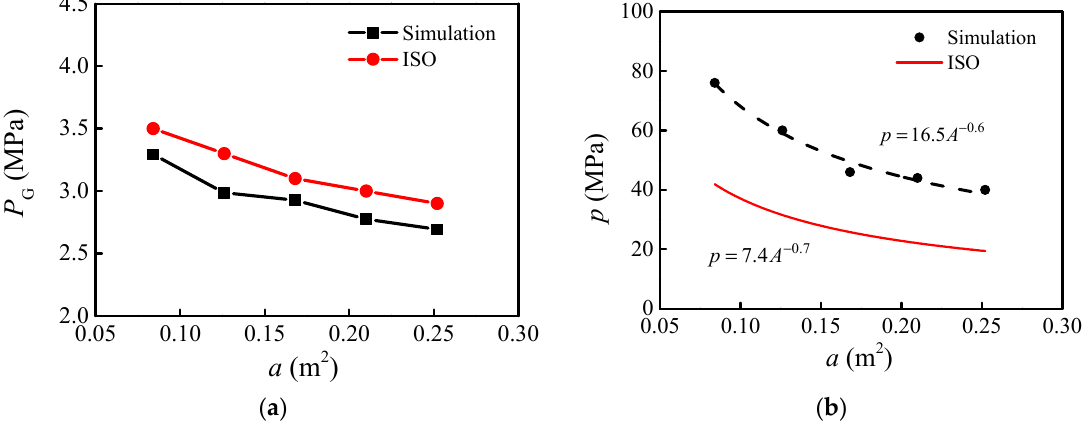
Figure 12. Effect of the contact area on high-pressure zones: ( a ) Global ice pressure; ( b ) Local ice pressure.